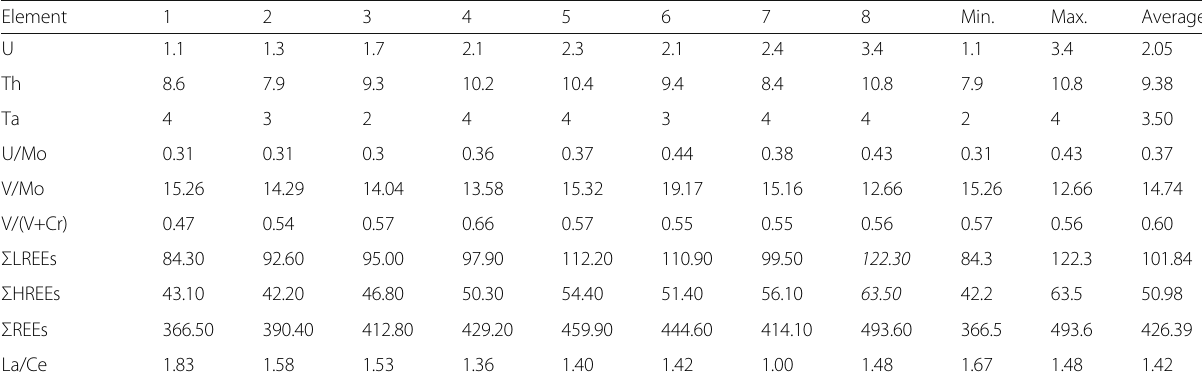
Table 1 Concentration of major (%), trace, and rare earth elements (ppm) of the studied carbonate rocks as well as ratios